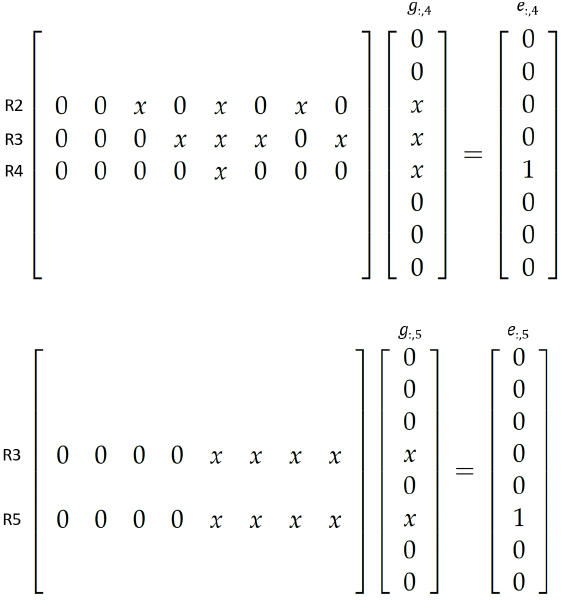
Figure 3. Computations performed from the two cores of Task 2 for the formulation of fourth and fifth columns of matrix G of the